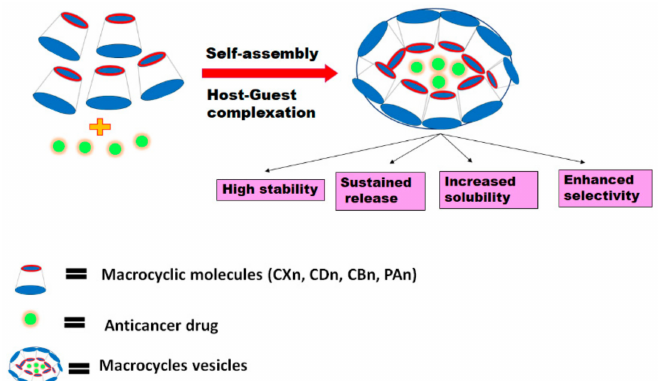
Figure 2. Schematic diagram representing the formation of host-guest vesicles and their impact on anticancer drug